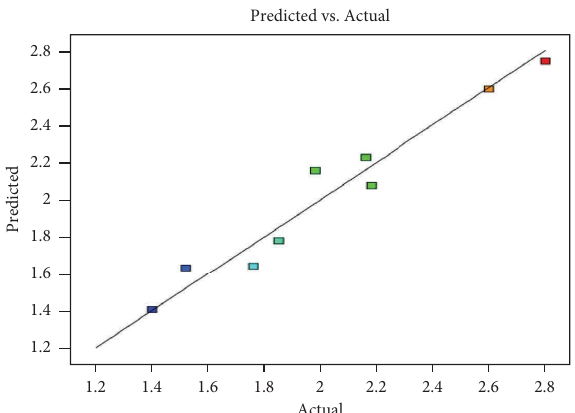
Figure 10: Simulated and actual outcome for fexural